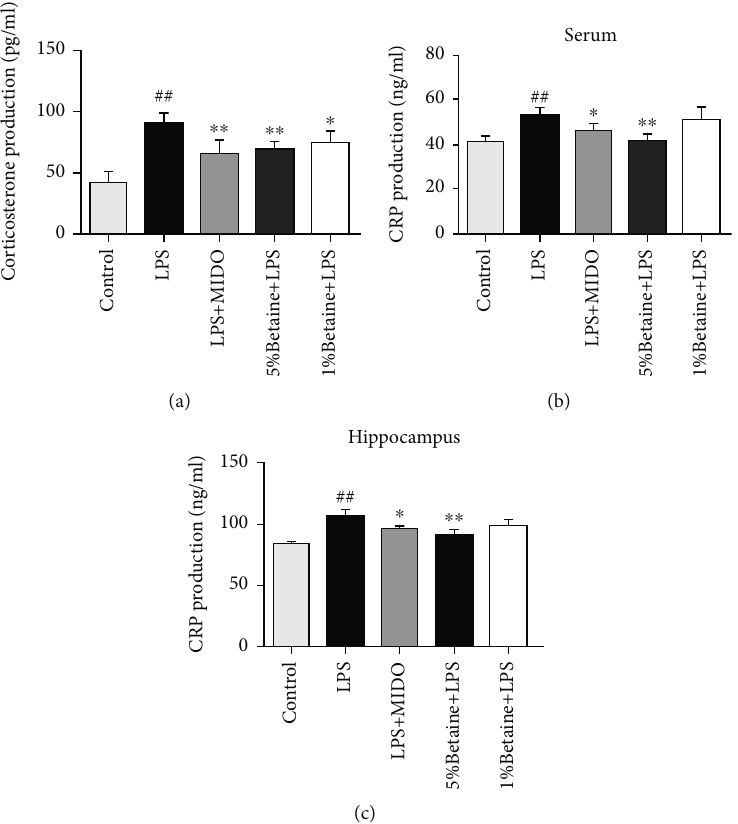
Figure 5: Determination of serum C-reactive protein (CRP) and corticosterone (CORT) levels in mice by ELISA. (a) Expression of corticosterone content in tissues. (b, c) Levels of C-protein in serum and hippocampus. ## P < 0 : 01 compared to the normal control group; ∗ P < 0 : 05 and ∗∗ P < 0 : 01 compared to the model group, n = 6